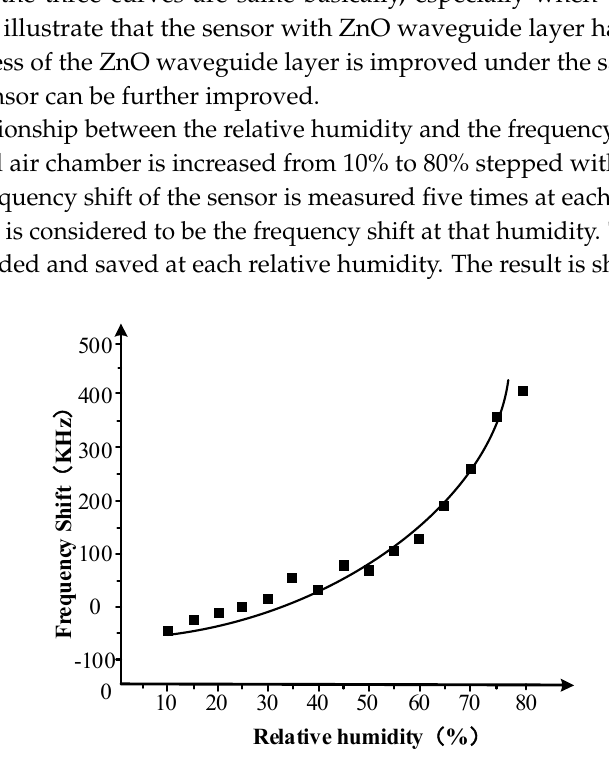
Figure 11. Hysteresis characteristics of the Love wave humidity sensor. According to Figure 11, the trends of the frequency shift in the process of desorption and moisture absorption is almost the same. The change in the frequency shift is largest and the largest hysteresis error is 6 %RH when the relative humidity is 60%. The result shows that the hysteresis of the sensor is good. The humidity response characteristics of the Love wave humidity sensor were measured at 25 °C and the result is shown in Figure 12. It can be seen from Figure 12 that the frequency shifts of the sensor were −6 kHz, 19 kHz, 40 kHz, 73 kHz, 135 kHz and 244 kHz when the relative humidity increased from 10% to 20%, 30%, 40%, 50%, 60% and 70%, respectively. The 80% response time is less 0